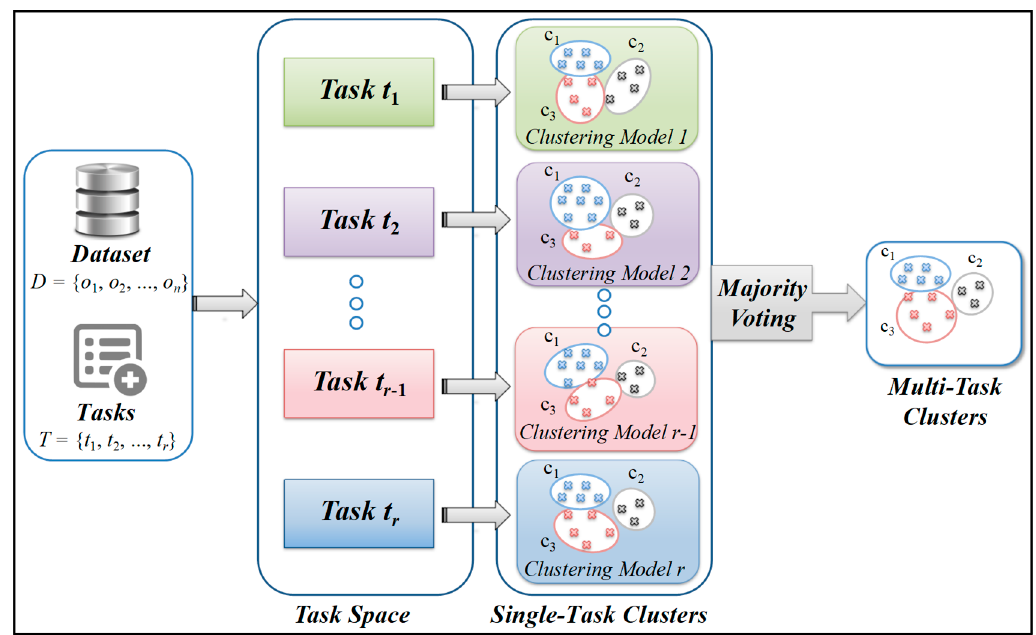
Figure 1. The general MV-MTC clustering scheme. Table 4. An example showing MV-MTC algorithm step by step. Ins. ID